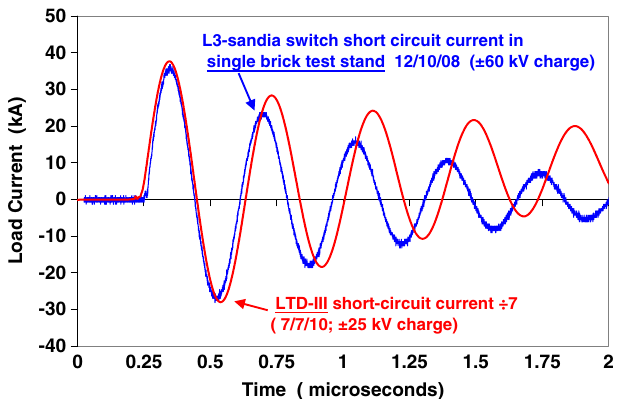
FIG. 11. Low-voltage, short-circuit currents in LTD-III com- pared with earlier data from our single brick test stand. Most of the increase in ringing period in LTD-III compared to the single brick test stand is caused by the thicker and longer spacer used to separate the capacitors on